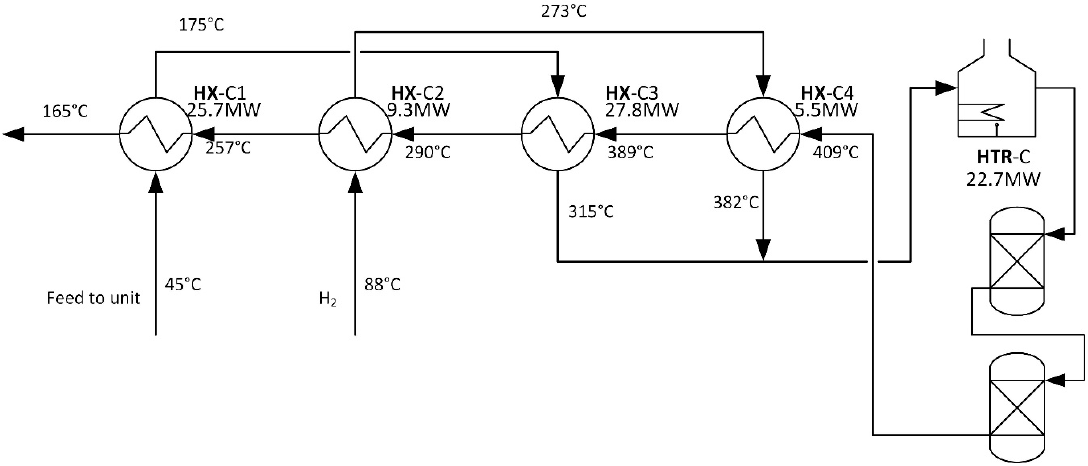
Figure A6. Current process scheme for selected part of Unit C.